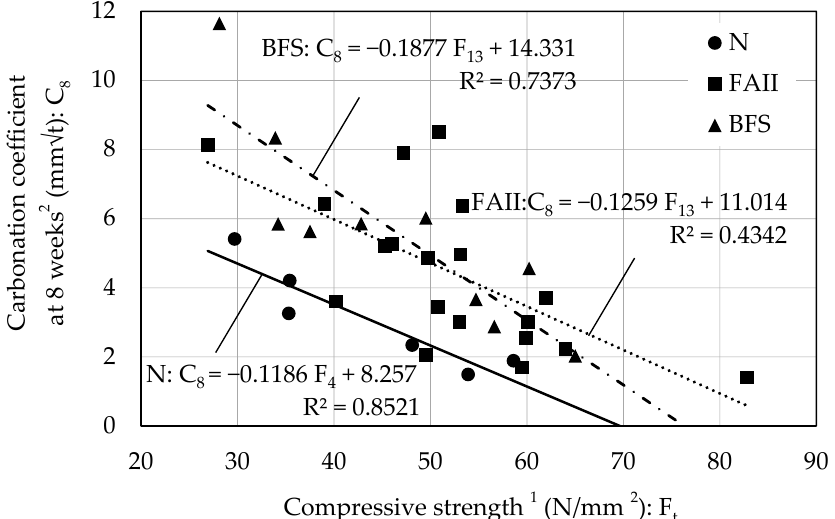
Figure 5. Correlation between compressive strength and carbonation coefficient. 1 Experimental results of N specimens at 4 weeks and FAII, BFS specimens at 13 weeks are shown. 2 For the specimens completely carbonated before 8 weeks, the data of the first and fourth weeks were